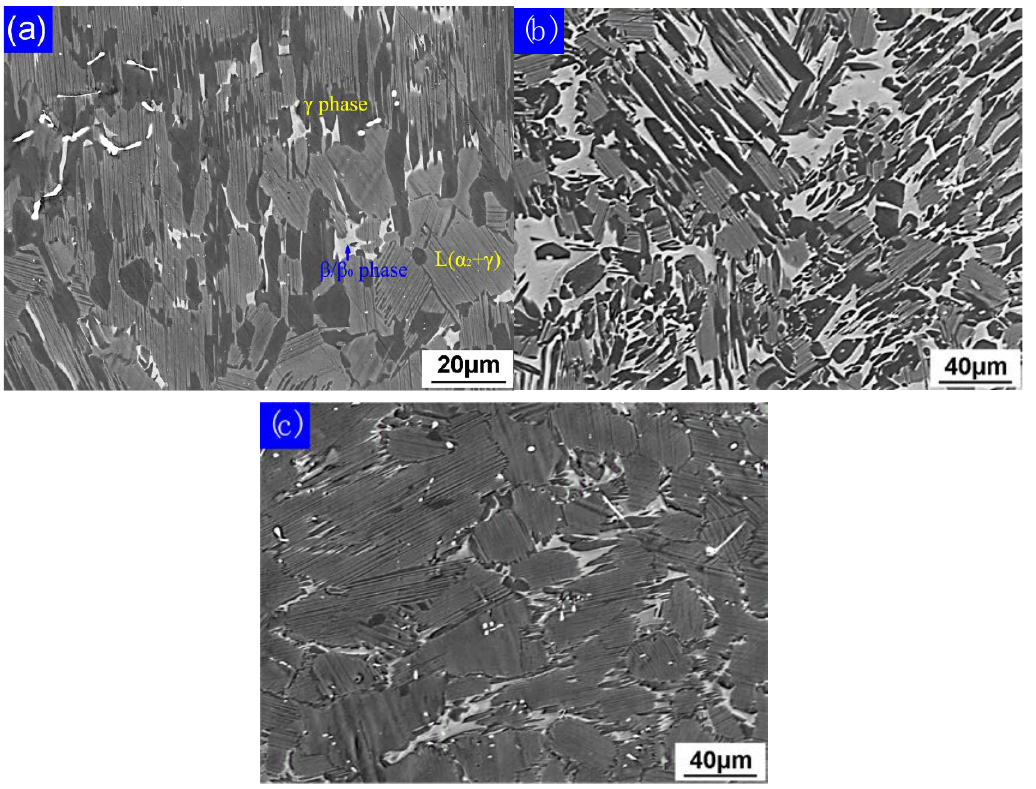
Figure 4. The microstructure of Ti-44Al-4Nb-4V-0.3Mo-Y alloy after heat treatment at: ( a ) 1210 °C, ( b ) 1240 °C, ( c ) 1260 °C for about 2 h and then furnace cooled.